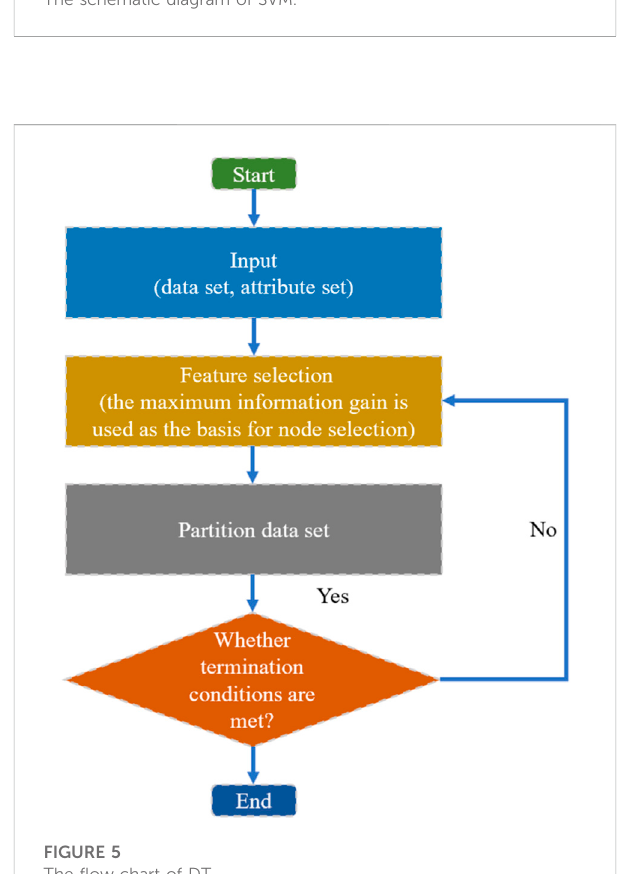
FIGURE 4 The schematic diagram of SVM.